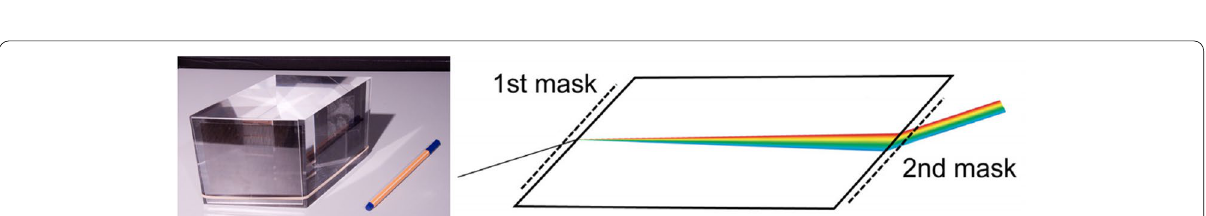
Fig. 25 The device of Hostettler et al. [68] consists of a prism and two masks. The prism refracts white lights into colored lights, and masks control the intensity of the